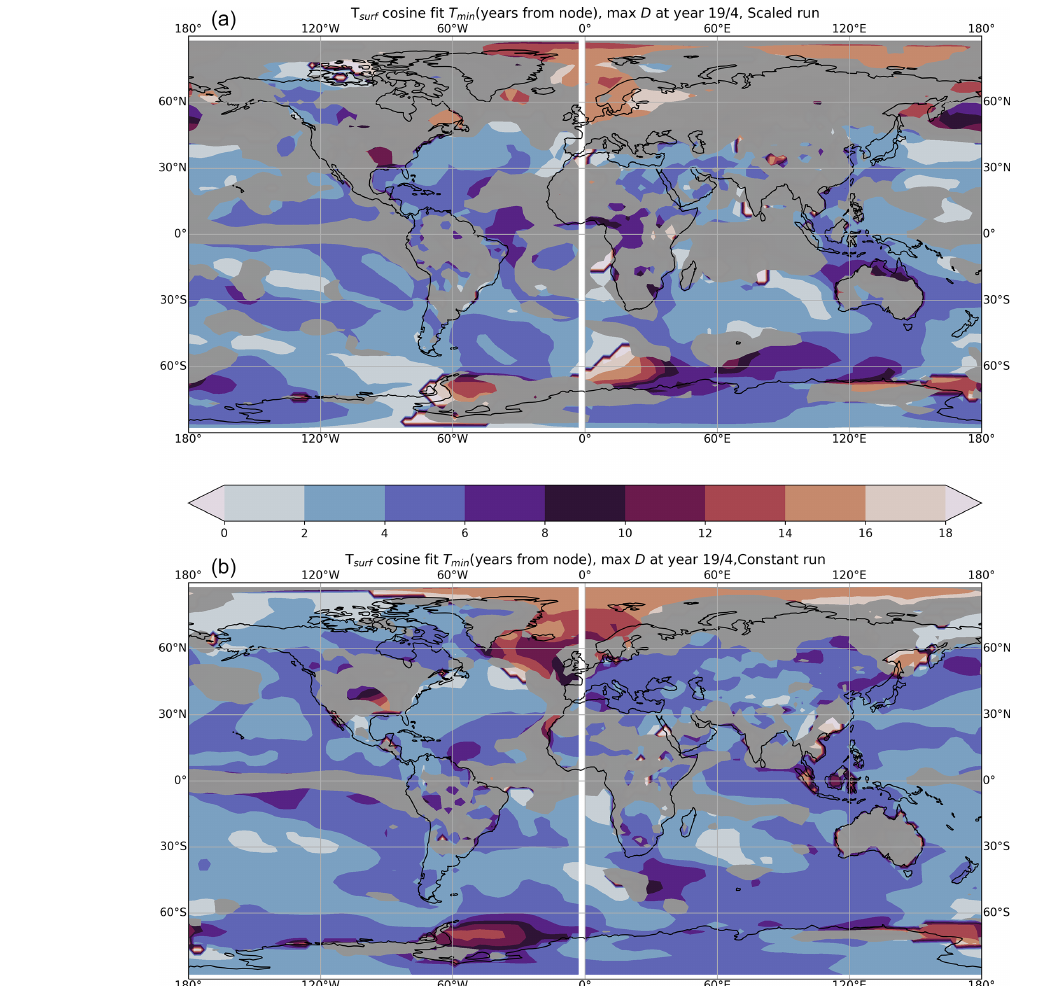
Figure 6. (a) Geographical variation of the phase of the sinusoidal trigonometrical fit to surface temperature (K) shown in Fig. 5. At each point, the colour denotes the phase in years (see Fig. 1a) where the fitted T surf reaches its most negative value. Note the cyclic colour interval, since a phase of 19 years is equivalent to a phase of 0 years. Blue colours correspond to phases associated with a globally averaged minimum in T surf (Fig. 4b). As with Fig. 5, grey shaded areas show where the amplitude is less than 2 standard errors of annually averaged T surf in the control integration and are used to denote areas where the response is likely to be noise. (b) As panel (a) but for the constant